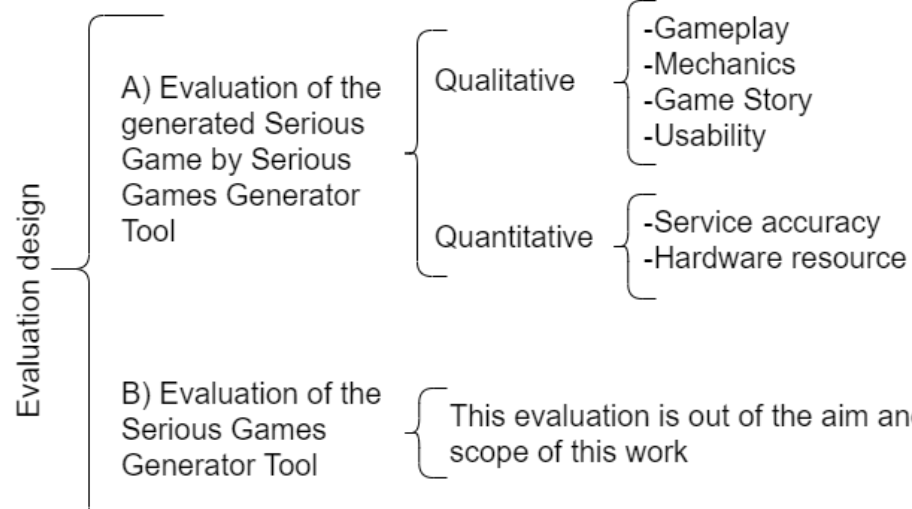
Figure 6. Evaluation